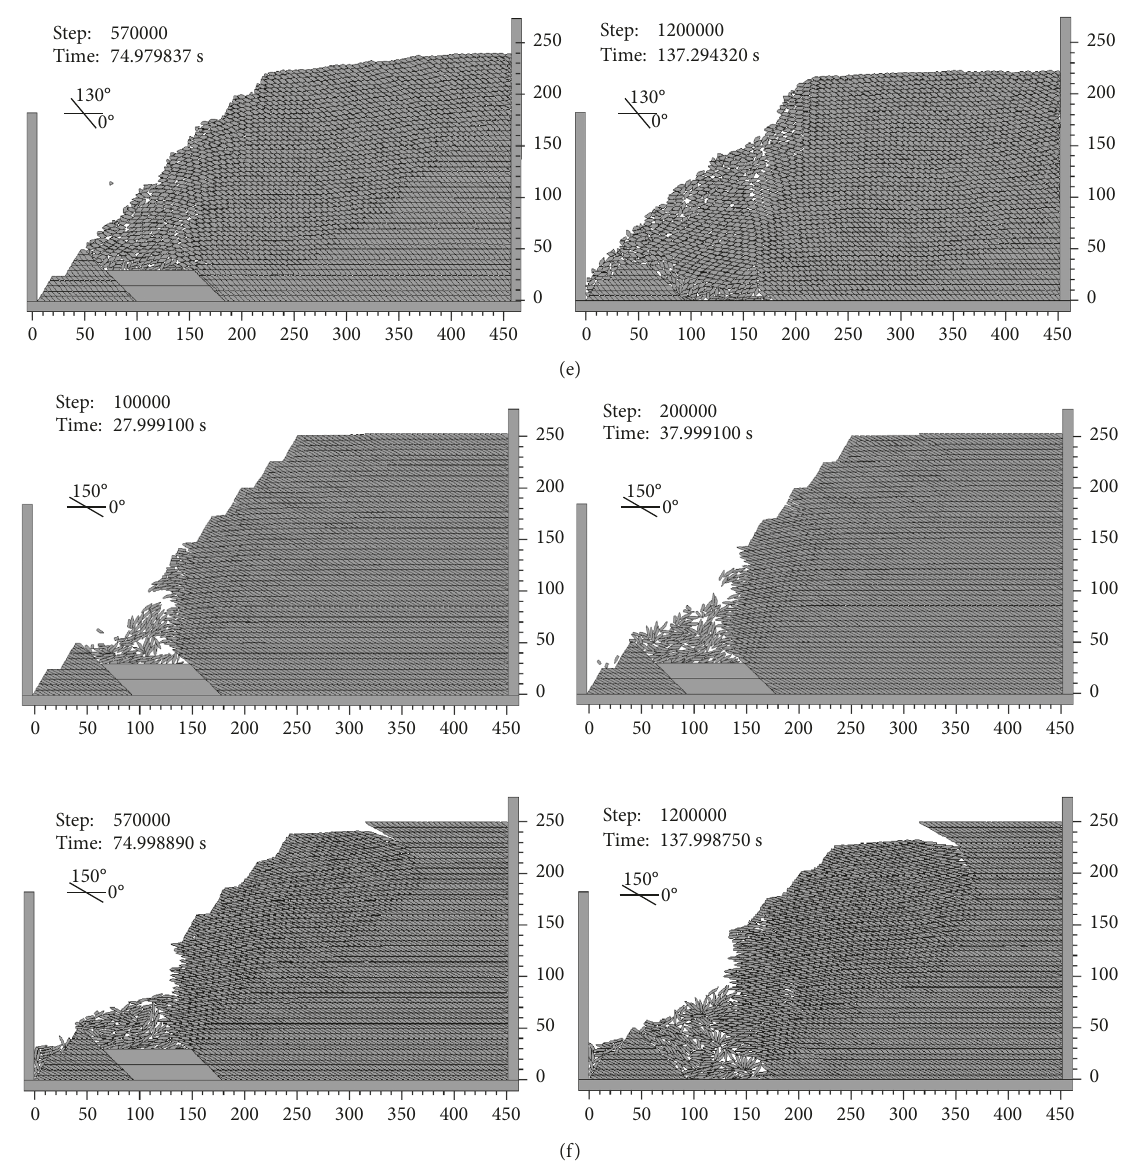
Figure 9: Slope instability in hanging-wall ore-body mining via induced caving for models J1 ∼ J6. (a) Model J1. (b) Model J2. (d) Model J4. (e) Model J5. (f) Model